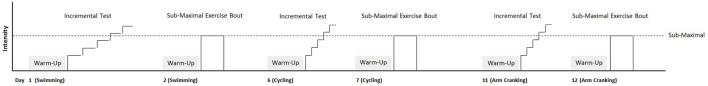
Schematic illustration of the testing protocols performed. See text for details.